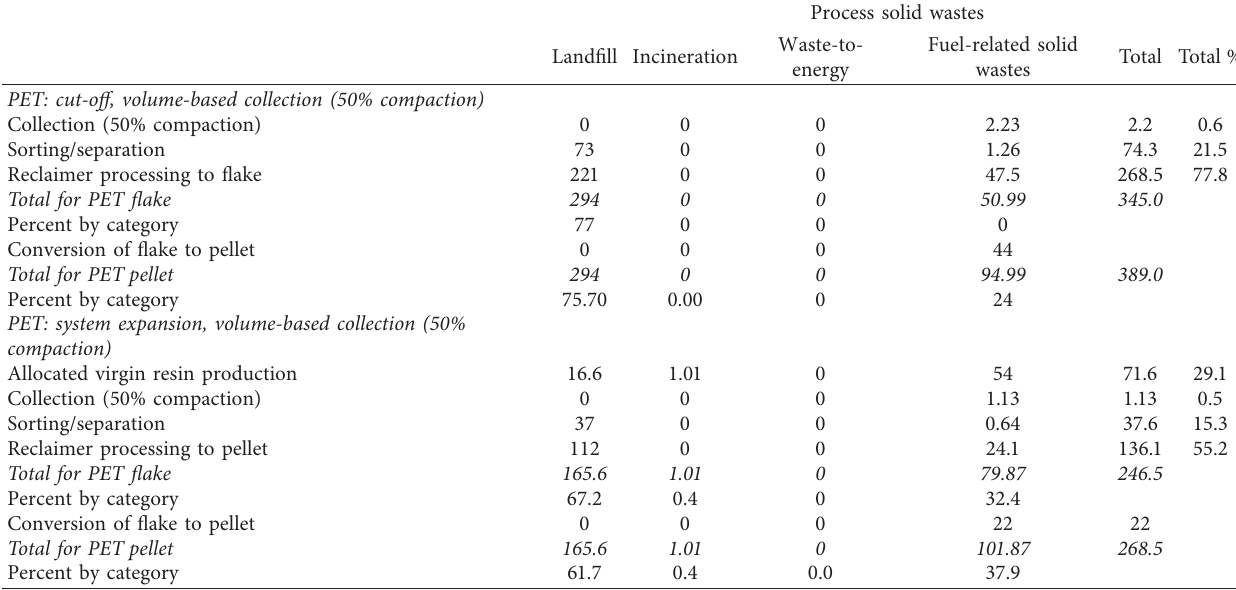
Figure 5: Greenhouse gas results for production of the recycled HDPE resin pellet (kg CO 2 equivalents per ton of resin) by the (a) life cycle stage and (b) emission category. Table 11: Solid waste for recycled PET resin (kg of waste per ton of resin).